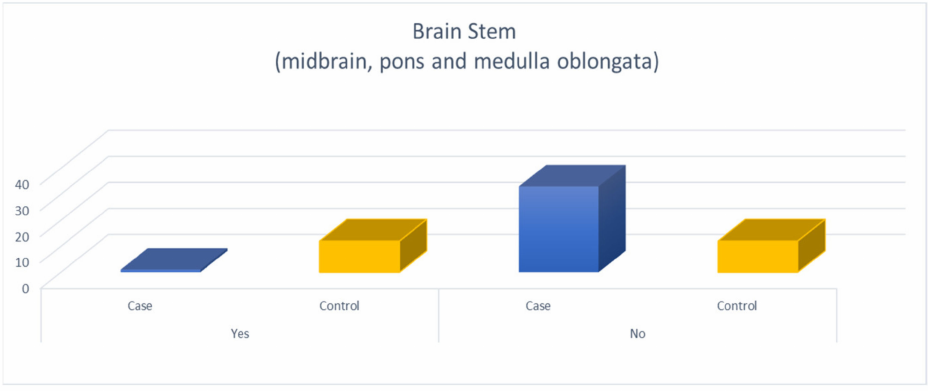
Figure 4. Comparison of patients with OSAHS and the control group for the presence of